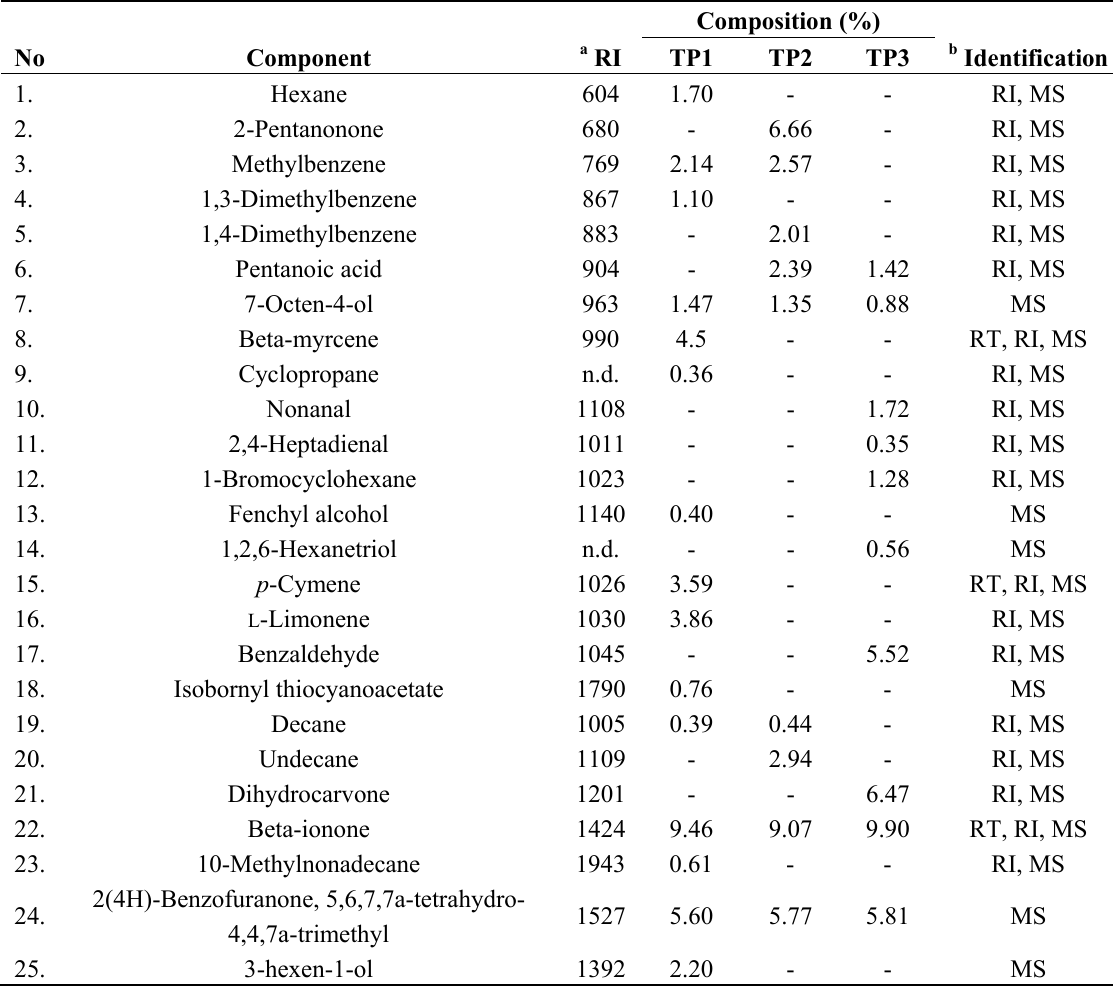
Table 1. Chemical composition of Trifolium pratense L. essential oil at three different stages of